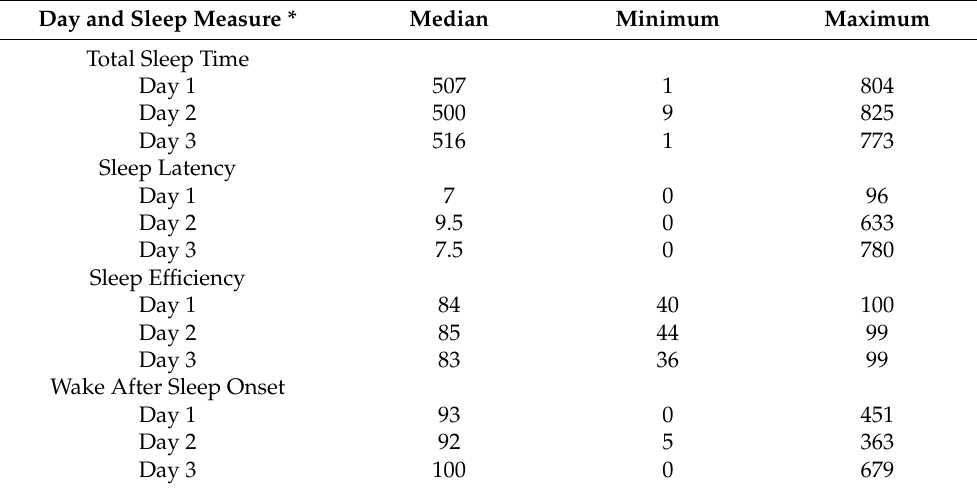
Table 1. Description of Nighttime Sleep Quality over 3 days (N =